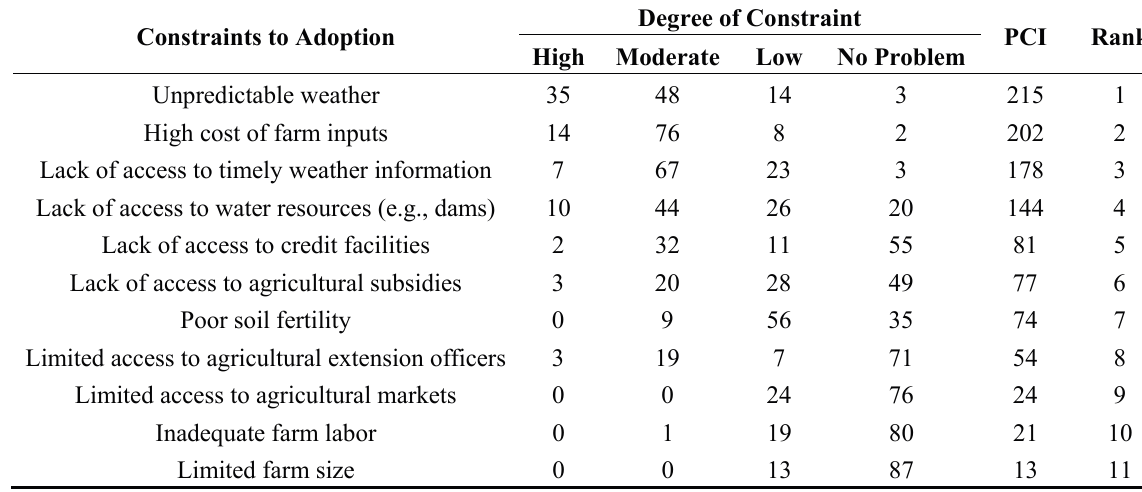
Table 5. Problems affecting implementation of adaptation practices in the Lawra district of Ghana (Number of respondents =